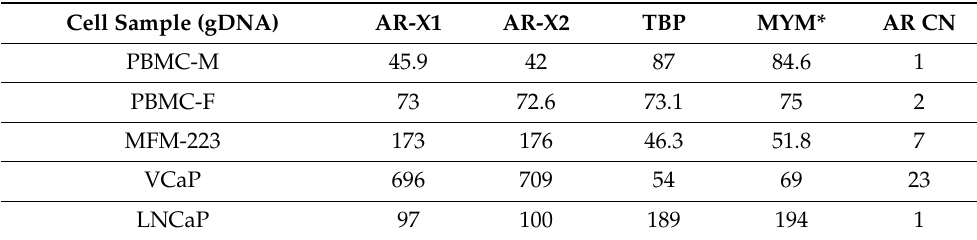
Table 3. AR-Amp-2 assay of gDNA from PBMCs and cell lines (concentration unit for each gene: copy/ µ L; M: male; F: female; AR CN as calculated in the Materials and Methods part, MYM* see Droplet Digital PCR